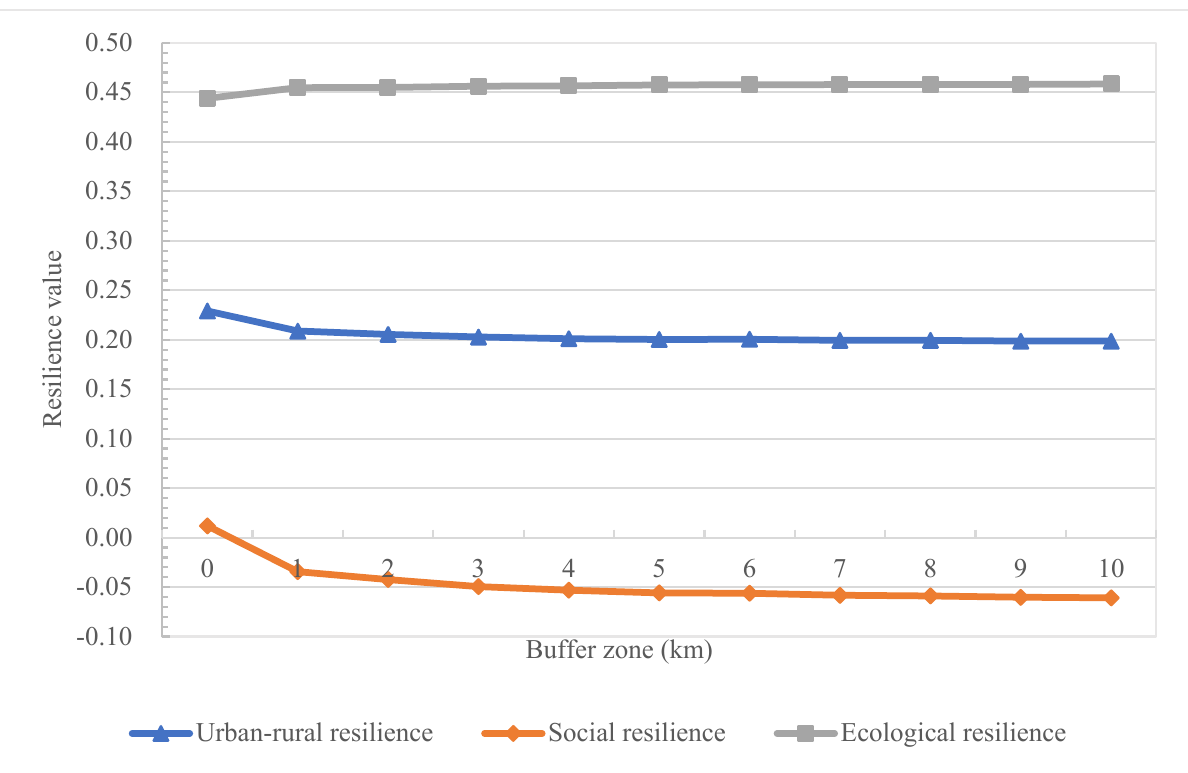
Figure 6. Resilience changes along the urban–rural system with the average value of all cities in the BHTUA. Meanwhile, on the prefectural city scale, generally, all cities reflect a decrease in resilience from the urban core to the rural outskirts, characterizing an urban–rural resilience divide (Figure 7). Combined with the spatial distribution characteristics in Figure 4, with the urbanization process, the resilience level gradually decreases from the urban center to the city’s periphery, and the area with a low resilience level changes from scattered distribution to contiguous distribution. Specifically, at the city level, comprehensive resilience decreases sharply from the urban center to its 3–5 km buffer zone and remains relatively stable in the rural regions (Figure 7). A similar trend goes for social resilience at the city level (Figure 8), while for ecological resilience, it increases sharply from the urban center to its 1–3 km buffer zone and remains relatively stable in the rural regions in this region, except for cities in the west and south of Hebei (Figure